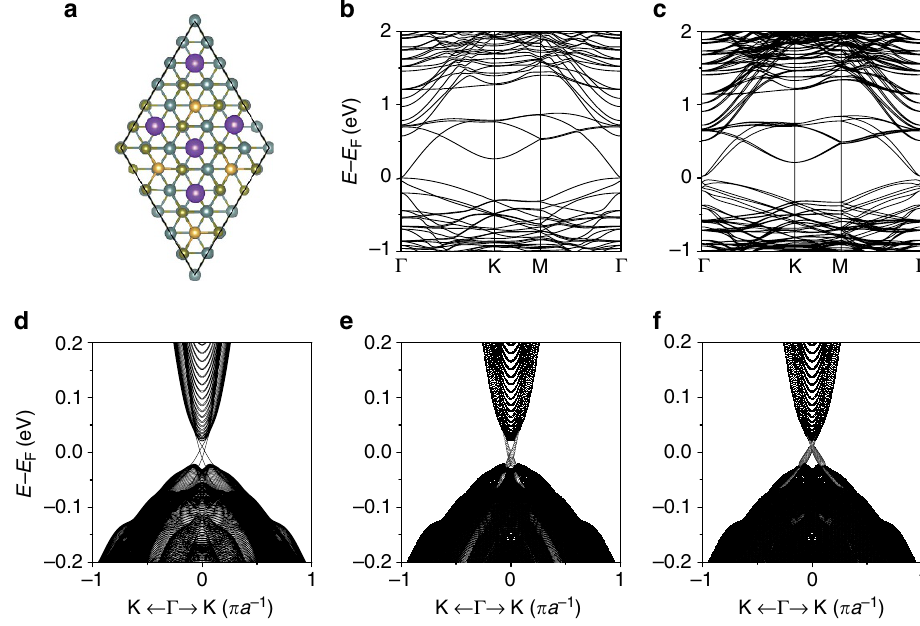
Figure 5 | Intrinsic 2D QSH for Au/GaAs(111) with surface n -doping. ( a ) Atomic structure of Au/GaAs(111) at 5/12 coverage of K atoms. ( b , c ) Band structures without and with SOC. ( d ) 1D ribbon band structure, showing gapless Dirac edge states within the energy window of SOC gap. ( e , f ) 1D ribbon band structure projected onto edge unit cell, showing opposite (left and right) edge state, respectively. In the projected bands, circle size denotes the weighting factor of the corresponding comparison between the fitted Wannier band and first-principles band is shown in Fig. 4b, showing excellent agreement. To clearly identify the non-trivial topology in Au/GaAs(111), we have calculated its spin Berry curvature, spin Hall